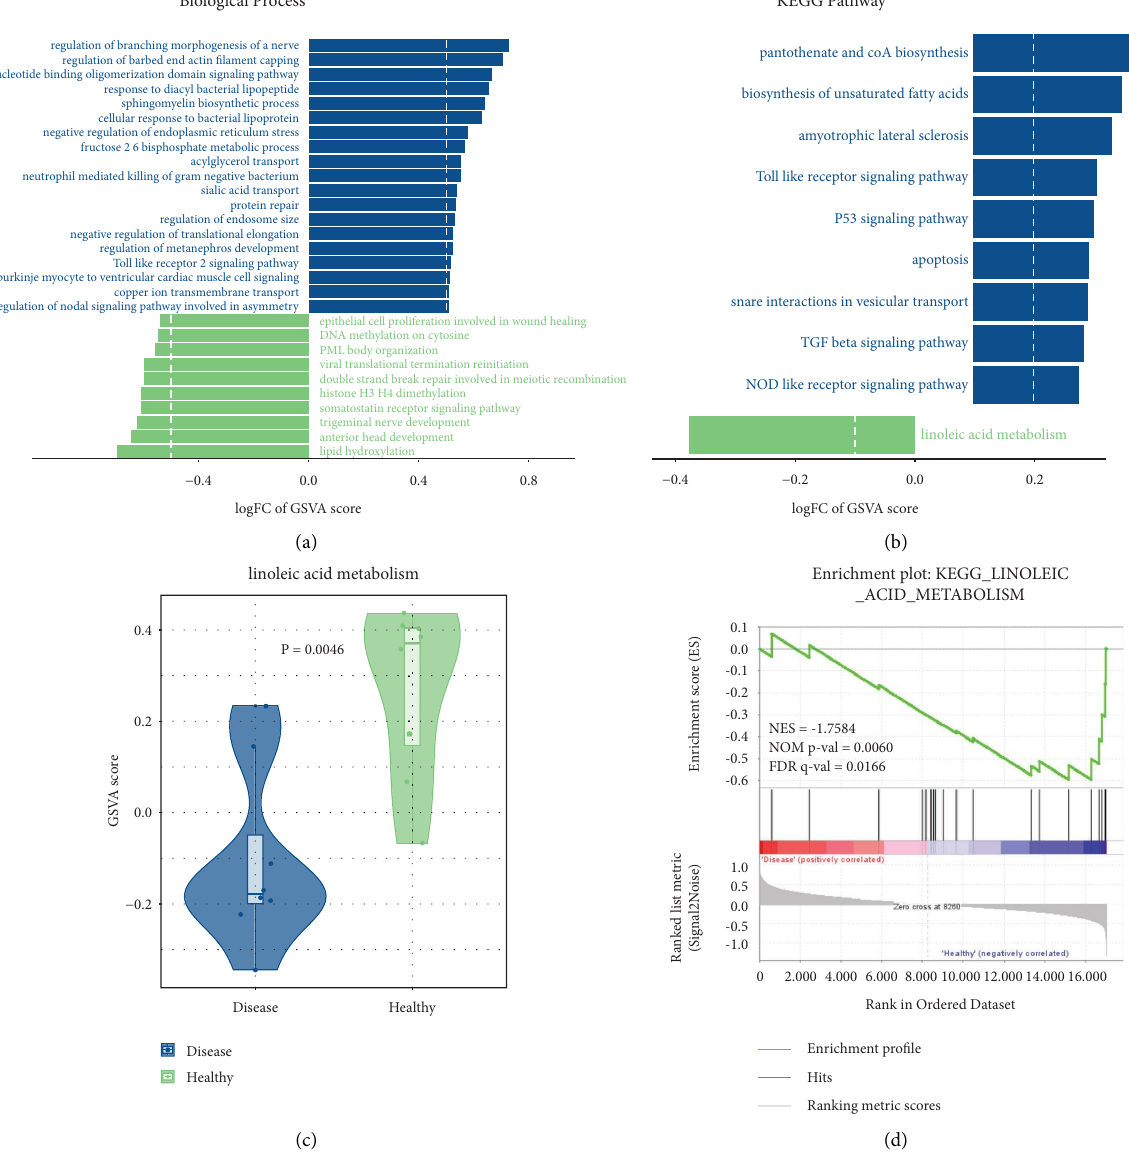
Figure 1: Gene set enrichment analysis. (a) Diferentially expressed BPs in the disease group and the healthy group. (b) Diferentially expressed pathways in the disease group and the healthy group. (c) Comparison of the GSVA enrichment score of the linoleic acid metabolism pathway between the disease group and the healthy group. (d) GSEA result of the linoleic acid metabolism pathway in the disease group and the healthy 29 genes involved in the linoleic acid metabolism pathway were obtained, and the PPI network is shown in Figure S2A. Te hub genes with the top 10 highest degrees were ALOX15, CYP2J2, CYP2C8, CYP3A4, CYP2C9, CYP1A2, CYP2C19, PLA2G3, PLA2G12A, and CYP2E1